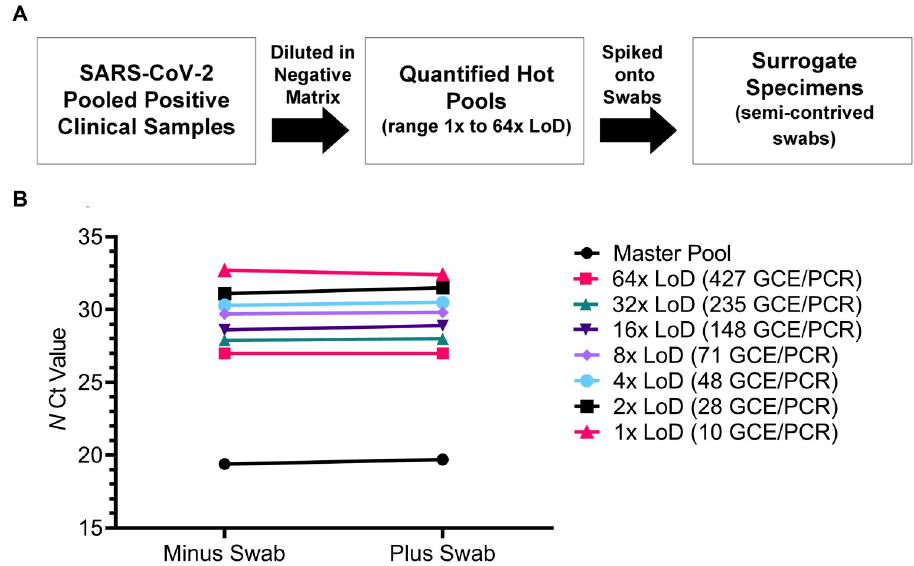
from dry polyester surrogate specimens was evaluated. N gene mean Ct values (n = 3 replicates) from hot pool serial dilutions tested directly (minus swab) were compared to Ct values from swabs spiked (plus swab) with hot pool serial dilutions.